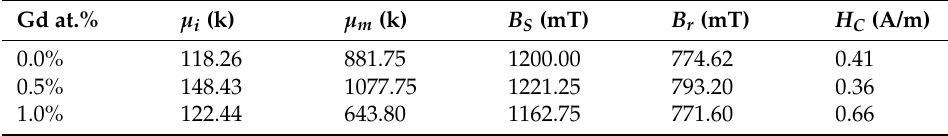
Table 5. Static soft magnetic